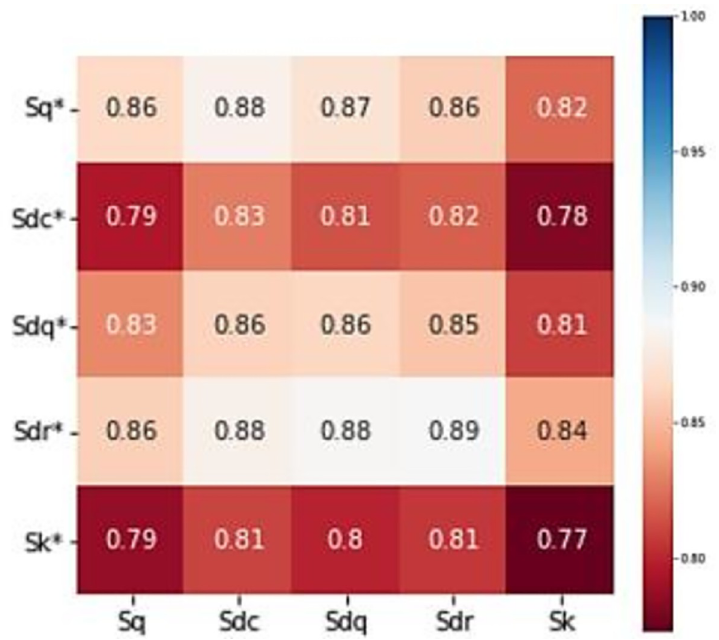
Fig 10. Parameter correlation of the surface morphology at the beginning and end of the running-in wear process.